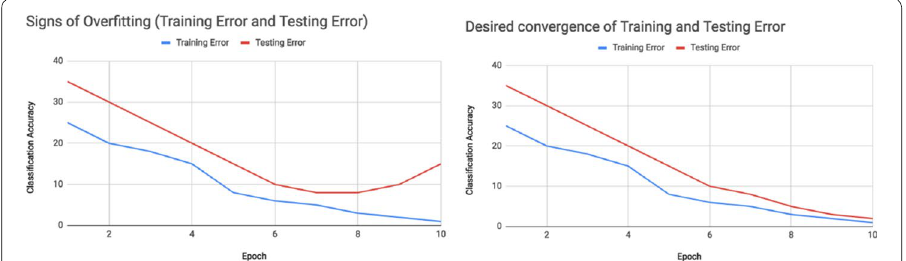
Fig. 1 The plot on the left shows an inflection point where the validation error starts to increase as the training rate continues to decrease. The increased training has caused the model to overfit to the training data and perform poorly on the testing set relative to the training set. In contrast, the plot on the right shows a model with the desired relationship between training and testing